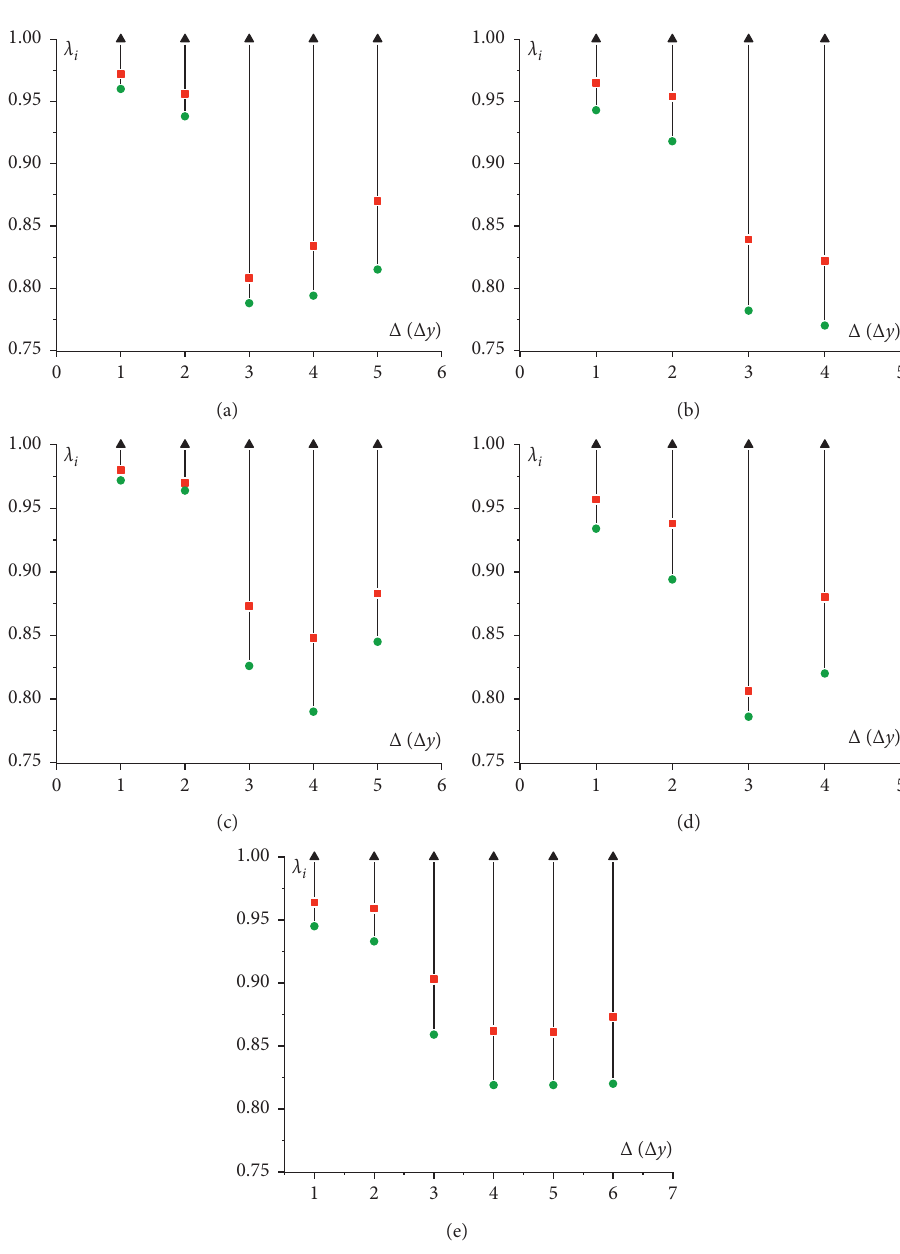
Figure 13: Bearing capacity degradation. (a) J-1, (b) J-2, (c) J-3, (d) J-4, and (e)